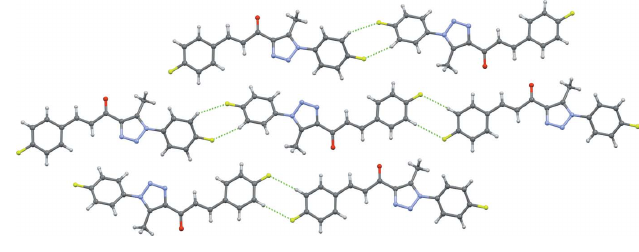
Figure 2 Intermolecular C—H (cid:2)(cid:2)(cid:2) F interactions forming